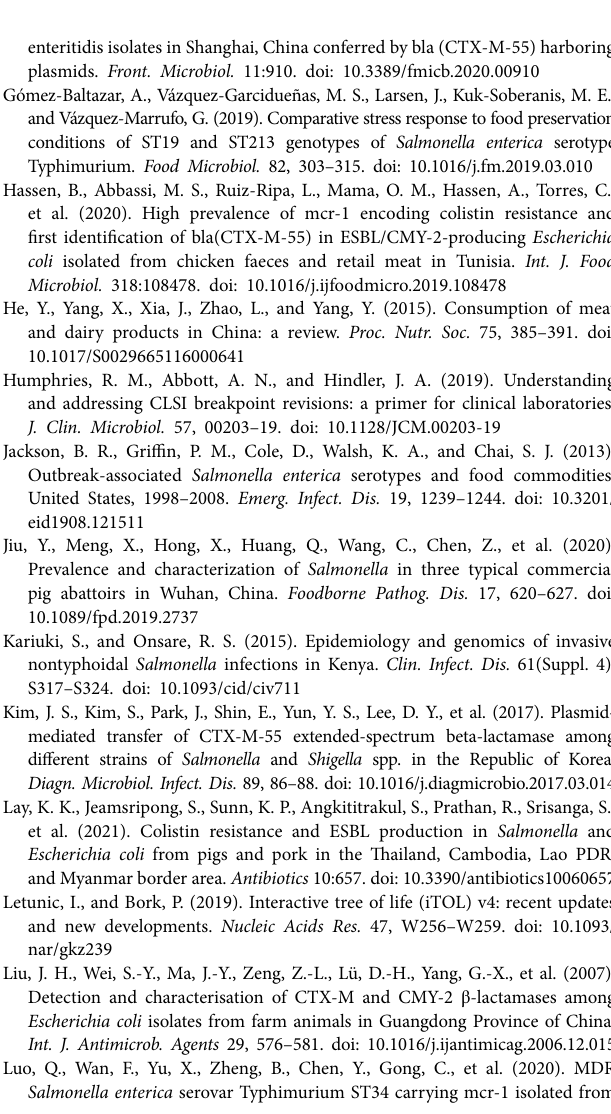
Supplementary Figure S2 | Genetic relatedness, year, city and hospital of the bla CTX-M-55 -positive S . Typhimurium isolates in Guangdong from 2010 to 2017. Supplementary Figure S3 | Genetic relatedness, year, city and hospital of the bla CTX-M-14 -positive S . Typhimurium isolates in Guangdong from 2010 to 2017. Supplementary Figure S4 | Genetic relatedness, year, city and hospital of the bla CTX-M-65 -positive S . Typhimurium isolates in Guangdong from 2010 to 2017. Supplementary Figure S5 | S1 endonuclease pulsed-field gel electrophoresis analysis of plasmids from the bla CTX-M-1G -positive S . Typhimurium isolates. Supplementary Figure S6 | S1 endonuclease pulsed-field gel electrophoresis analysis of plasmids from the bla CTX-M-9G -positive S . Typhimurium isolates. Supplementary Figure S7 | PBRT types that bla CTX-M -positive S . Typhimurium isolates (A) all PBRT types that bla CTX-M -positive S . Typhimurium isolates (B) PBRT types that bla CTX-M-55 -positive S . Typhimurium isolates. (C) PBRT types that bla CTX- M-14 -positive S . Typhimurium isolates. (D) PBRT types that bla CTX-M-65 -positive S . Typhimurium